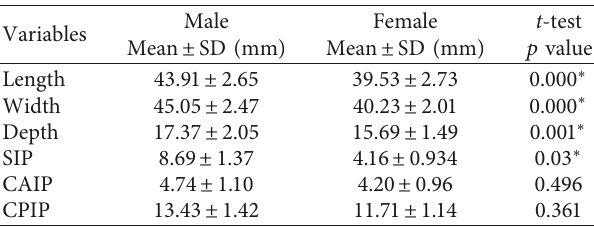
Table 1: Mean palatal arch dimensions, SIP, CAIP, and CPIP in Jordanian adults.